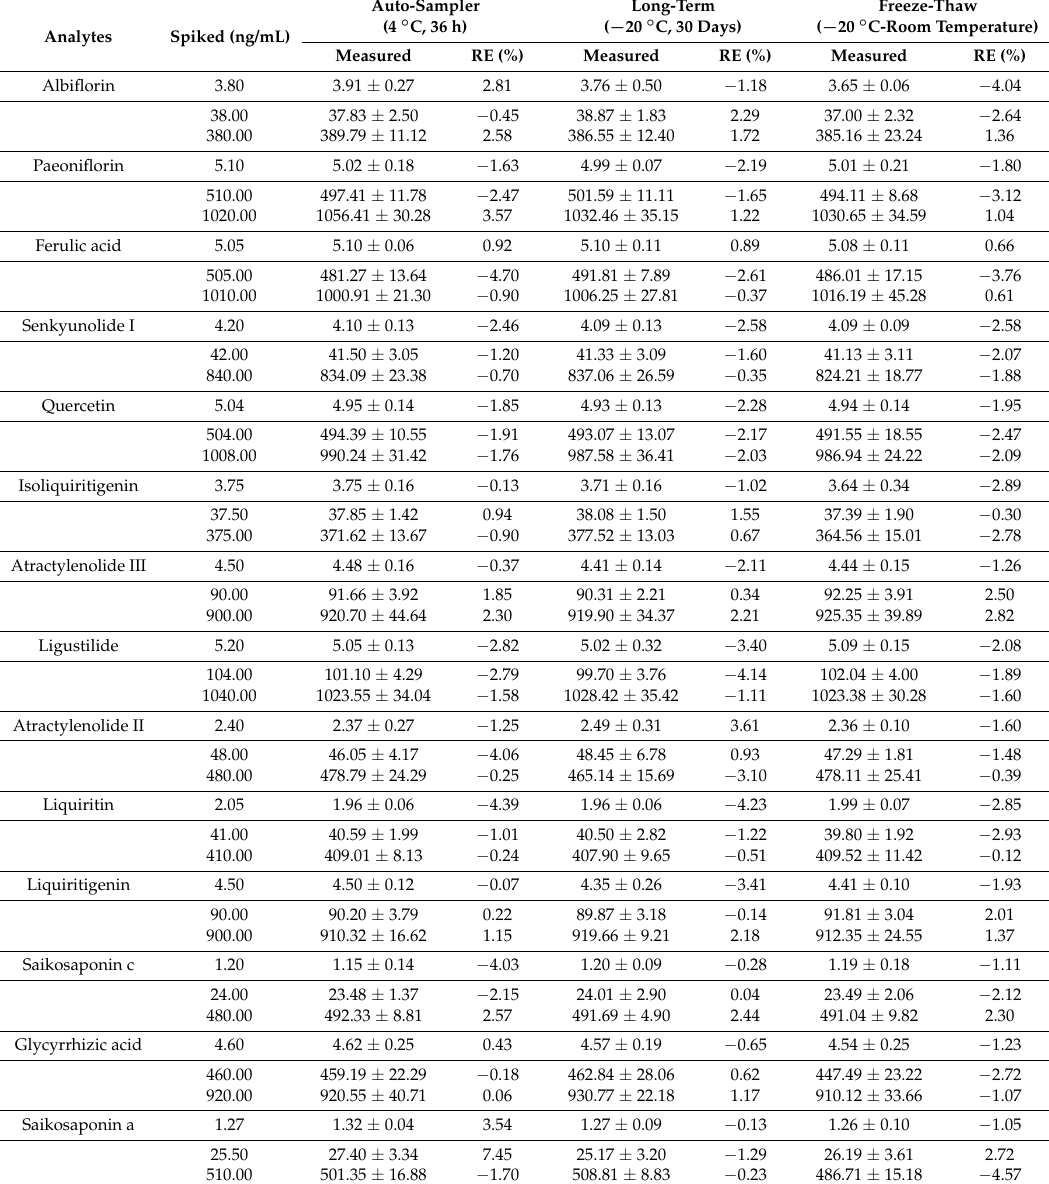
Table 4. Stability evaluation results ( n =